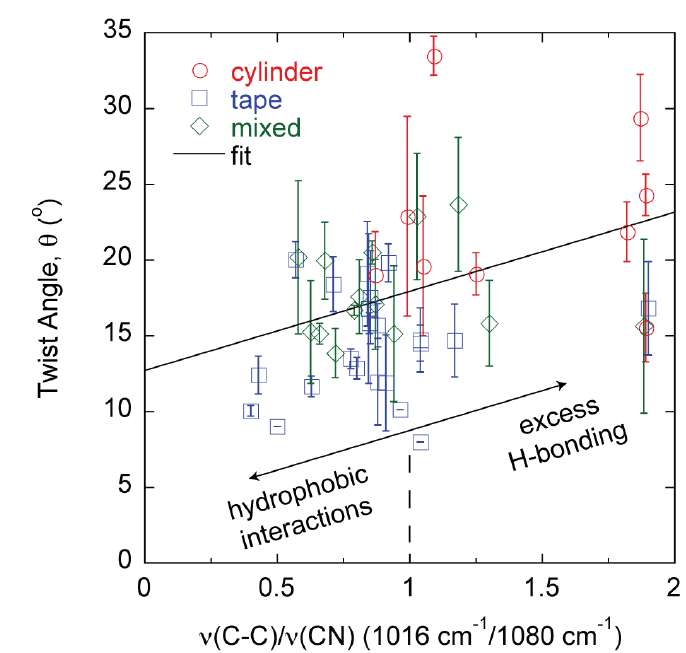
Figure 5. Fiber morphology, θ , can be predicted by the hydrogen bonding state of constituent protein amino acid side chains as described by the FTIR absorbance ratio ν (C–C)/ ν